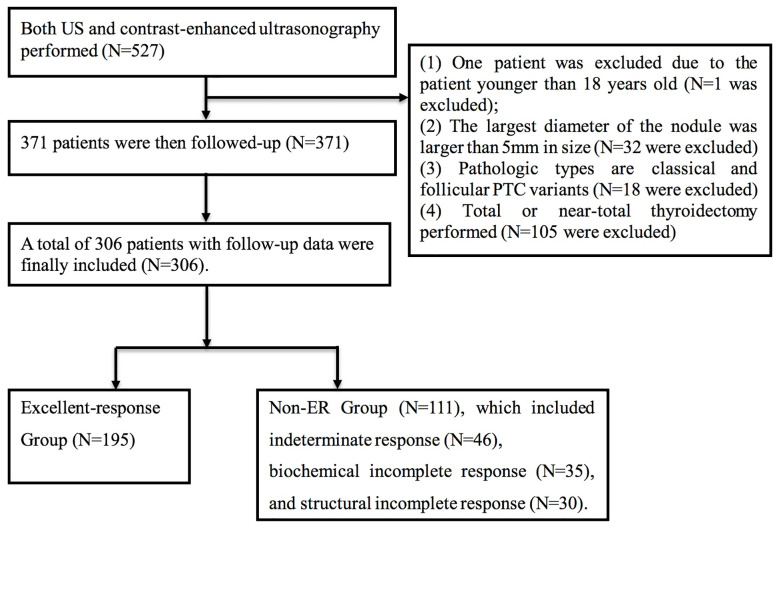
Flowchart of patient selection and inclusion in the study.